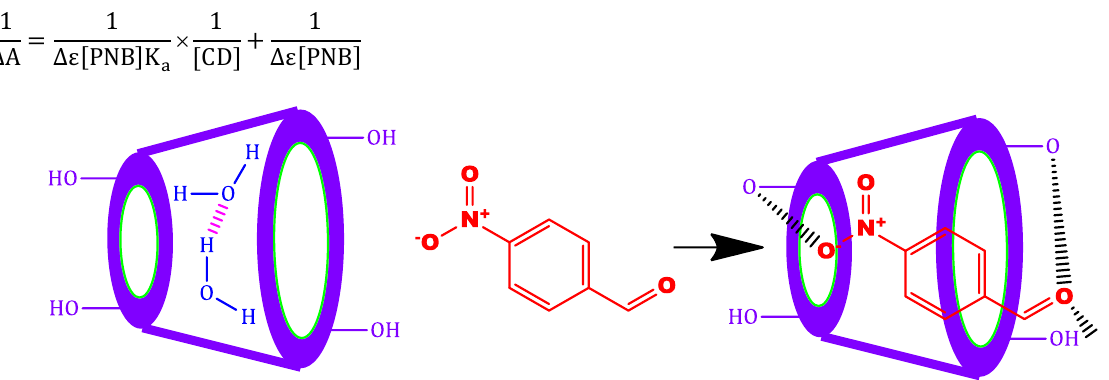
Figure 8. Plausible Schematic representation of mechanism for the formation of 1:1 inclusion complex of PNB with β